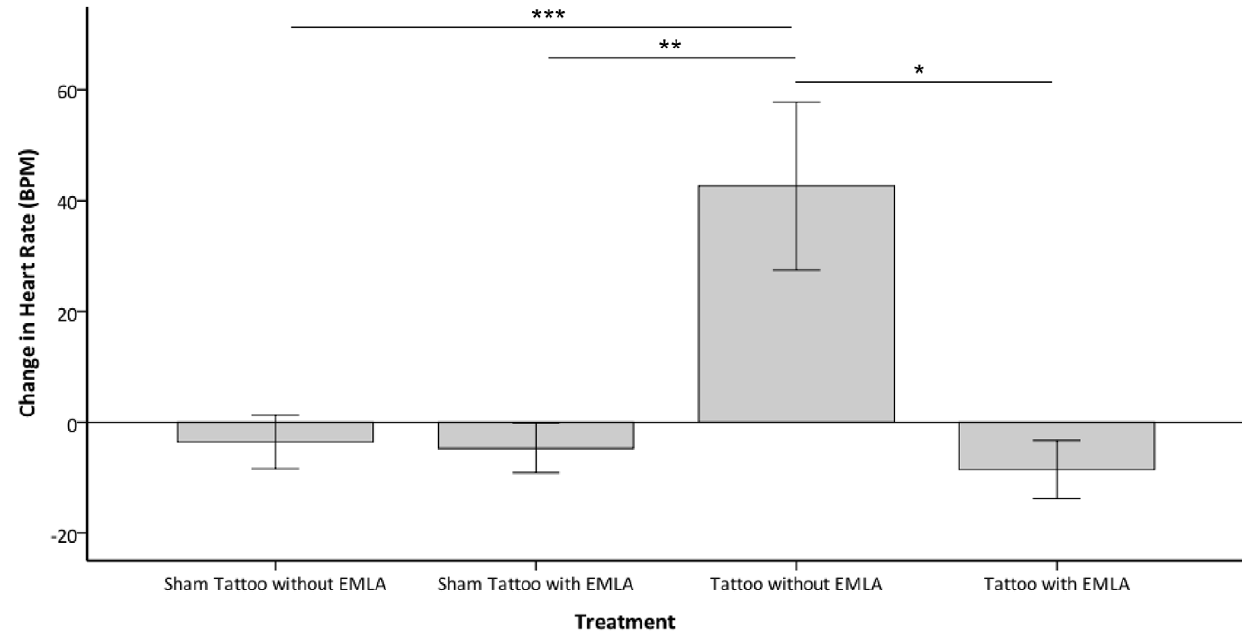
Figure 1. Change in mean heart rate from pre to post-procedure. Change in mean heart rate (beats per minute 6 1 SE) from pre to post- procedure observed in rabbits (y-axis) when undergoing the various treatments (x-axis); sham tattooing with and without prior application of EMLA and tattooing with and without prior application of EMLA (n=8 per treatment) ( w P=0.022, ww P=0.031, www P=0.004).